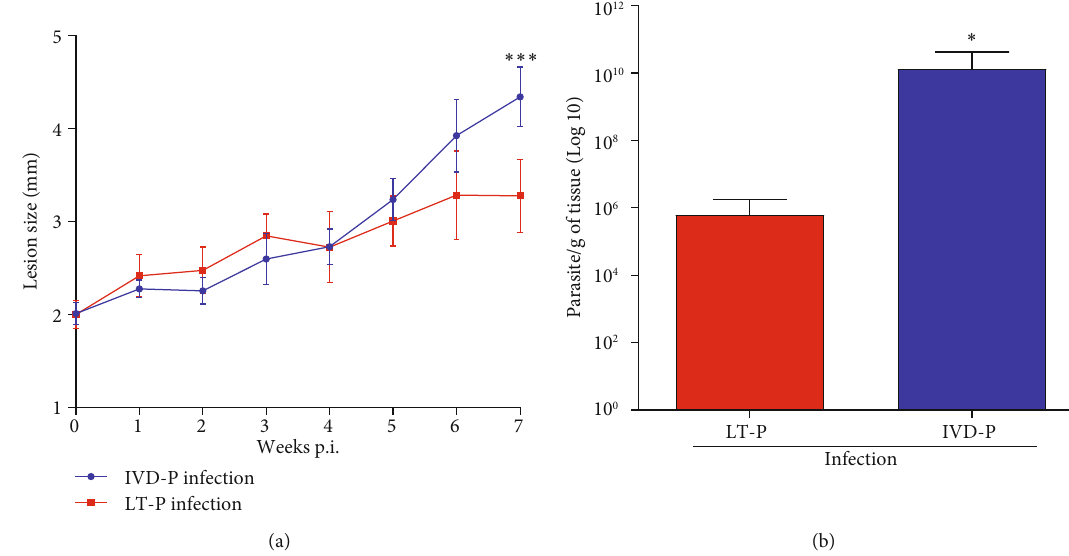
Figure 4: Evaluation of BALB/c mice infection with IVD-P or LT-P. (a) Lesion size (millimeter (mm)) measurements ( n = 5 ). Each point represents the average of the measurements ( n = 5 ). Student ’ s t -test ∗∗∗ P < 0 : 001 . (b) Parasite load in the hind footpad ( n = 5 ). Bars denote the average of 5 measurements, and error bars denote the SD. Mann-Whitney test ð ∗ P < 0 : 05 Þ . Data are representative of 2 independent